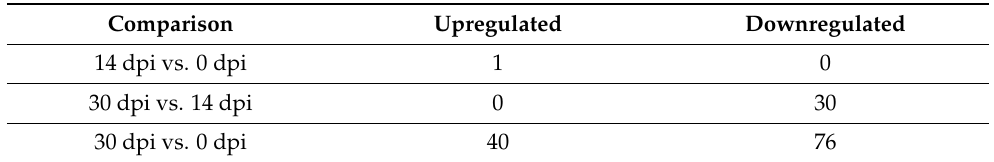
Table 2. Numbers of GO terms significantly enriched for lists of up- and down-regulated DEGs in different samples comparisons.